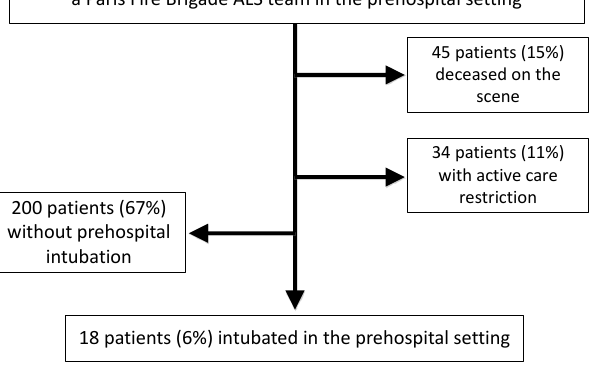
Figure 1. Patient flowchart.